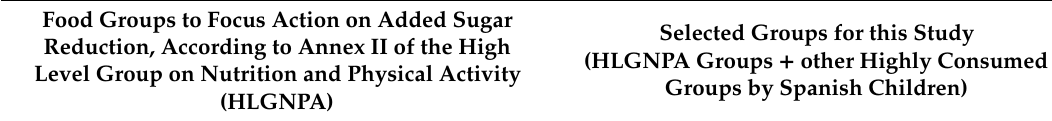
Table 1. Selected food and beverage groups for this